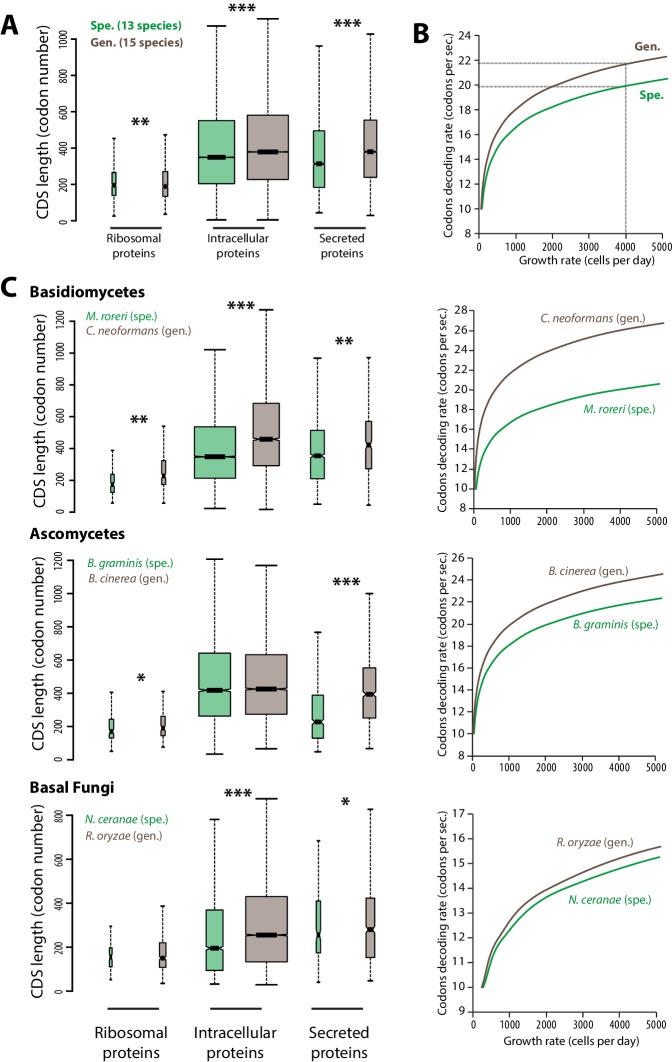
Contrasted length distribution in proteomes is expected to increase selection on codon optimization in generalist fungi.(A) Distribution of length (number of codons) in the ribosomal, intracellular and predicted secreted proteomes of 13 specialist fungal parasites and 15 generalist fungal parasites. (B) Relationship between codon decoding rate (number of codons translated per second) and cell growth rate of typical specialist and generalist fungi predicted by a cellular model of protein translation. Dotted lines highlight the higher codon decoding rate required in generalist fungi compared to specialist fungi to achieve a growth rate of 4000 cells produced per day. (C) Distribution of length in the proteomes (left) and relationship between codon decoding rate and cell growth rate (right) in related specialist and generalist fungi from the Basidiomycetes, Ascomycetes and Basal Fungi. The width of boxplots is proportional to the number of values. Spe., specialist (green); Gen., generalist (brown). Welch’s t-test p: *<10−01, **<10−04, ***<10−08.DOI:
http://dx.doi.org/10.7554/eLife.22472.00210.7554/eLife.22472.003Figure 1—source data 1.Equations forming the mathematical model of protein biosynthesis related to protein length and codon optimization parameters; list of parameters and variables used for modeling of growth rate based on proteome properties; and values of parameters used for modeling of growth rate based on proteome properties.